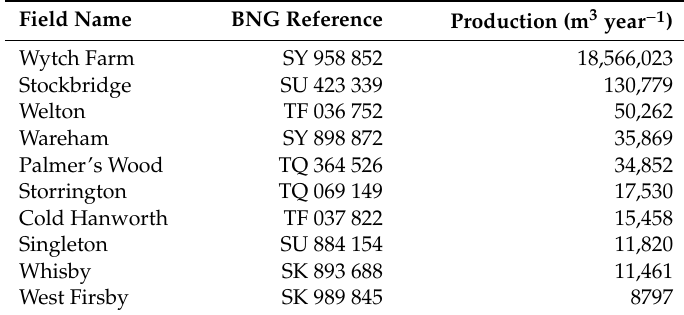
Figure 2. Map showing the extent and depth of Triassic and Permian aquifers in the UK. The extents of potential low-temperature geothermal fields in these aquifers are also shown. The fields detailed in Table 1, shown as green dots, fall into two groups: in the Wessex Basin in the south; and in the East Midlands farther north. CH, Cold Hanworth; PW, Palmer’s Wood; SB, Stockbridge; SI, Singleton; ST, Storrington; WA, Wareham; WE, Welton; WF, West Firsby; WH, Whisby; and WY, Wytch Farm. Modified after [42]. British National Grid co-ordinates (north and east) are in 100 km intervals. Table 1. Water production rates in UK onshore